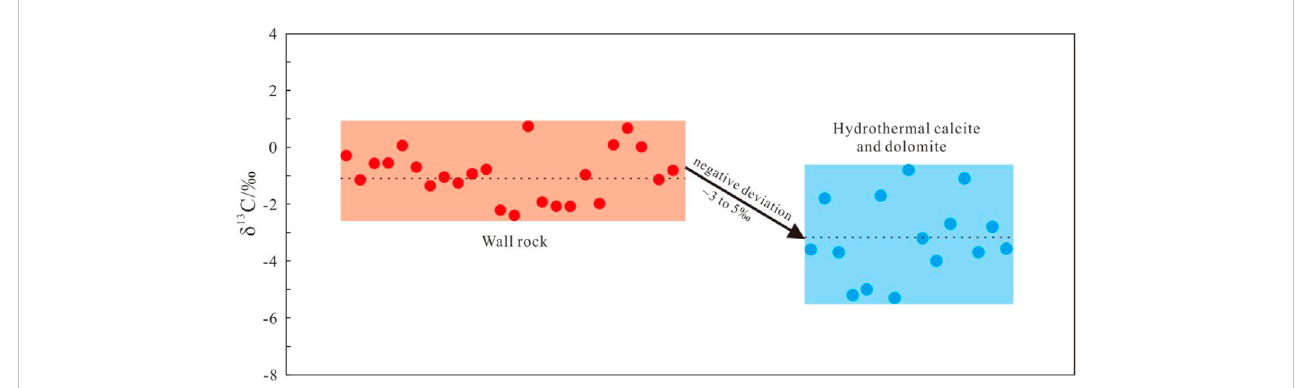
FIGURE 14 C isotope correlation between hydrothermal carbonate minerals and wall rocks in Maoping lead-zinc deposit (Data are from Han et al., 2007;Wei, 2011; He et al.,